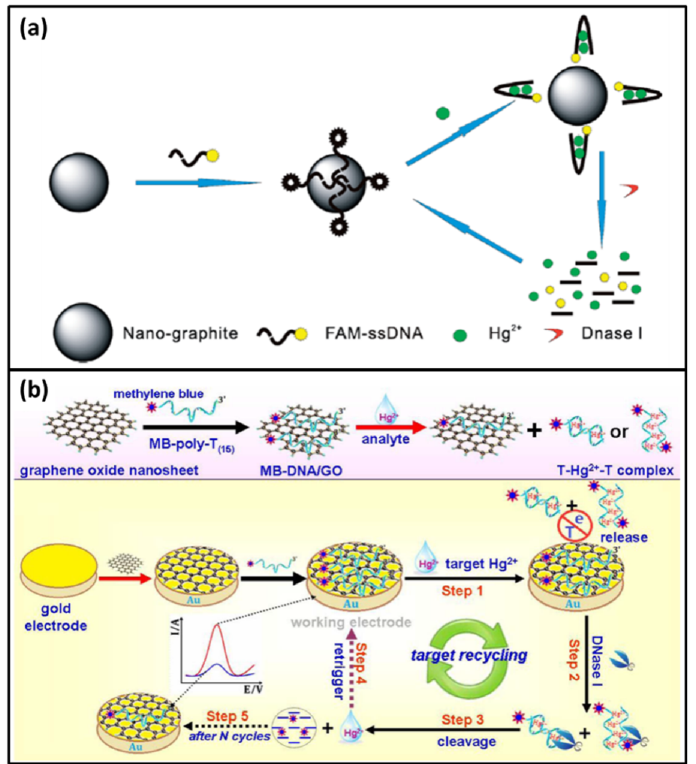
Figure 7. ( a ) A scheme of a nano-graphite-DNA hybrid fluorescent biosensor for Hg 2+ detection based on DNase I. Reprinted with permission from [70]. Copyright 2014 Royal Society of Chemistry ( b ) A scheme of a novel electrochemical biosensor to monitor Hg 2+ based on DNase I-assisted target recycling. Reprinted with permission from [73]. Copyright 2016